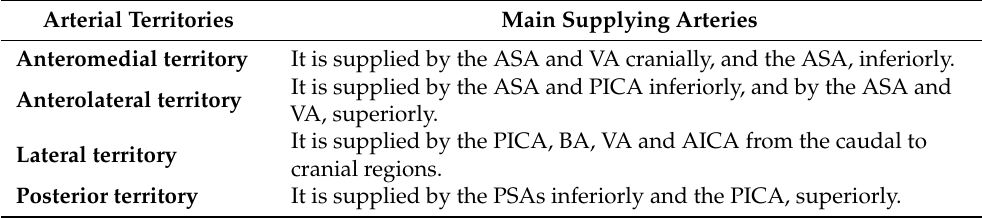
Table 1. Arterial territories of the medulla and main arterial supply .